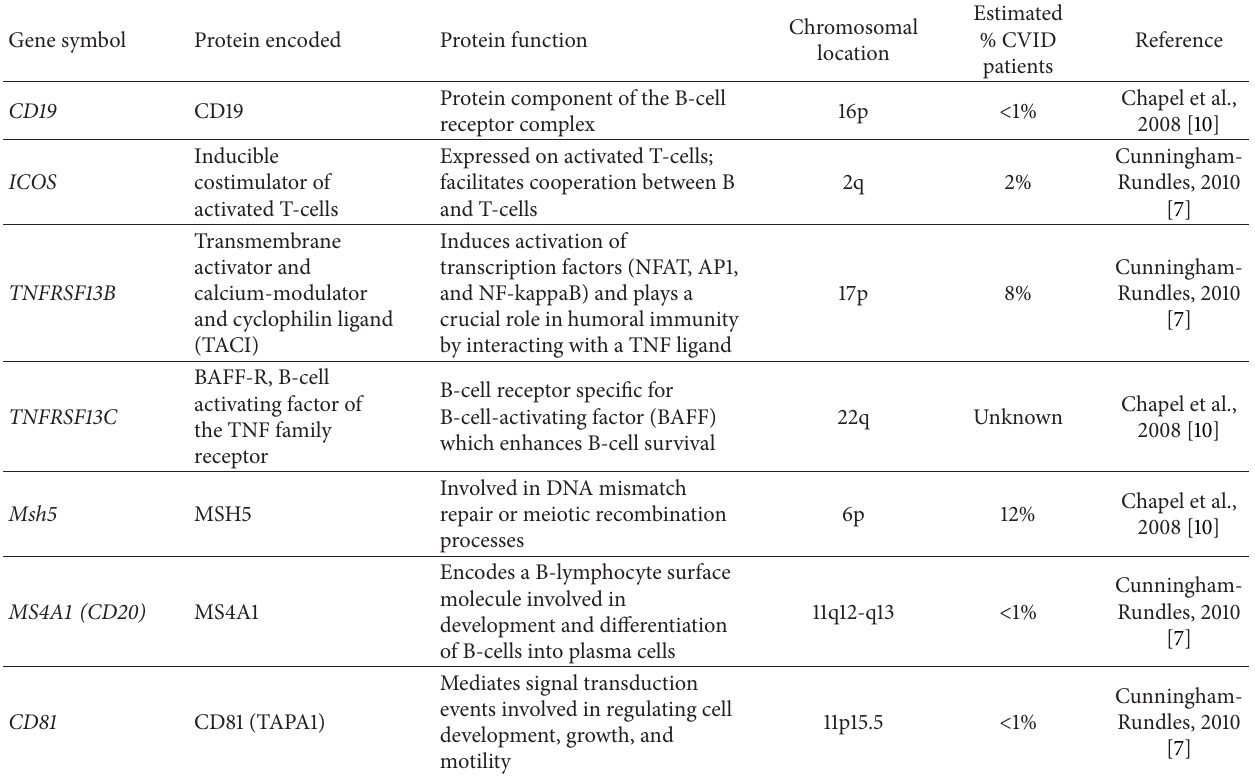
Table 3: Genes implicated in CVID [7,